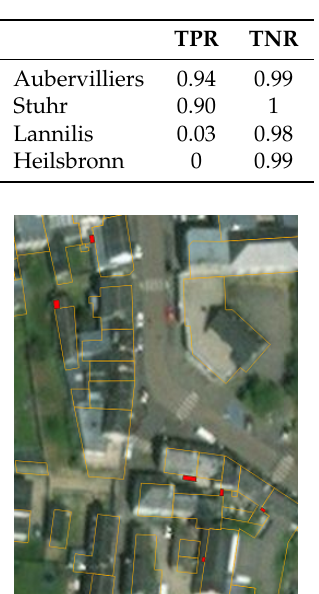
Table 5. Predictions of OSMWatchman with C A + B ∗ without user features.